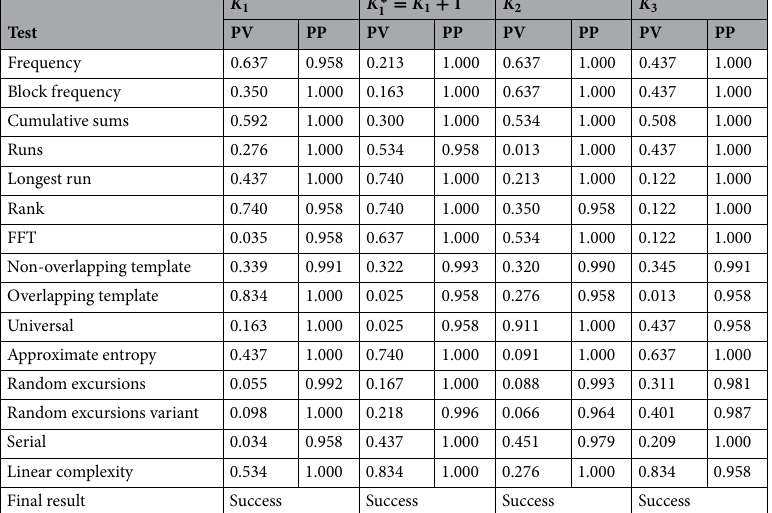
Table 5. NIST results for the PRNG.